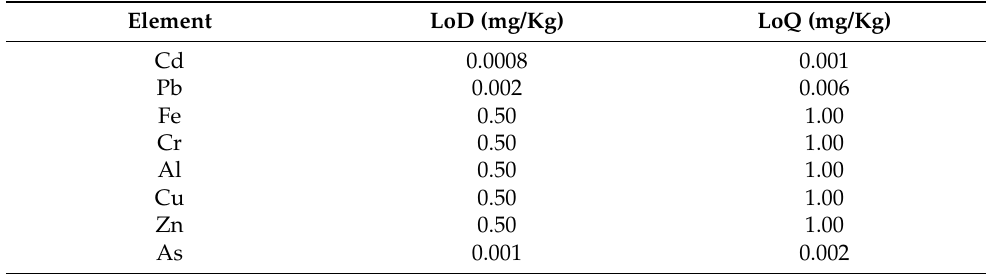
Table 1. Method detection and quantification